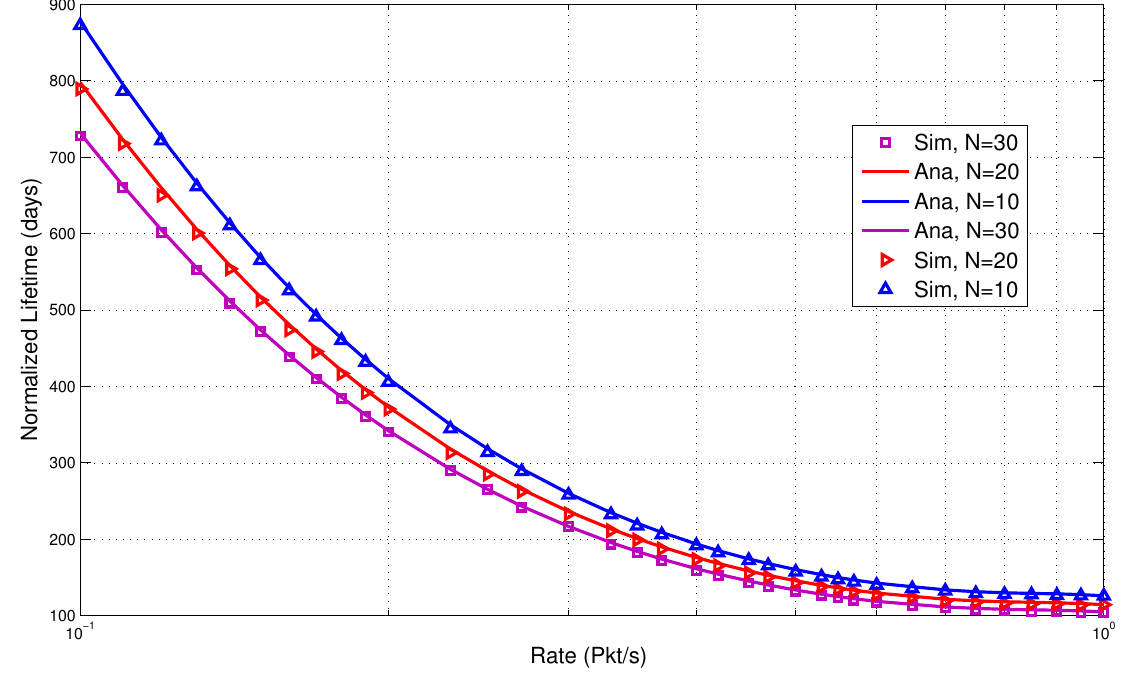
Figure 21. Combined traffic